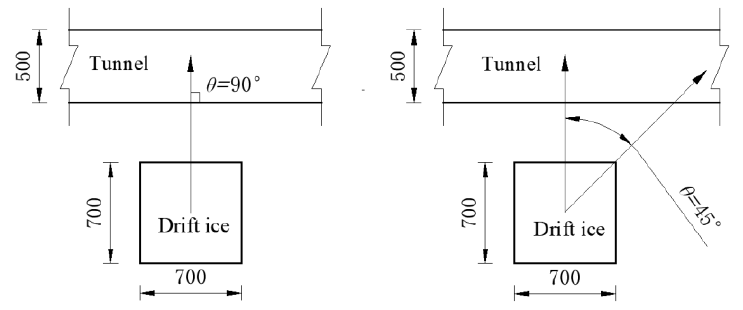
Figure 10. Schematic diagram of collision angle between drift ice and tunnel lining (unit: mm).